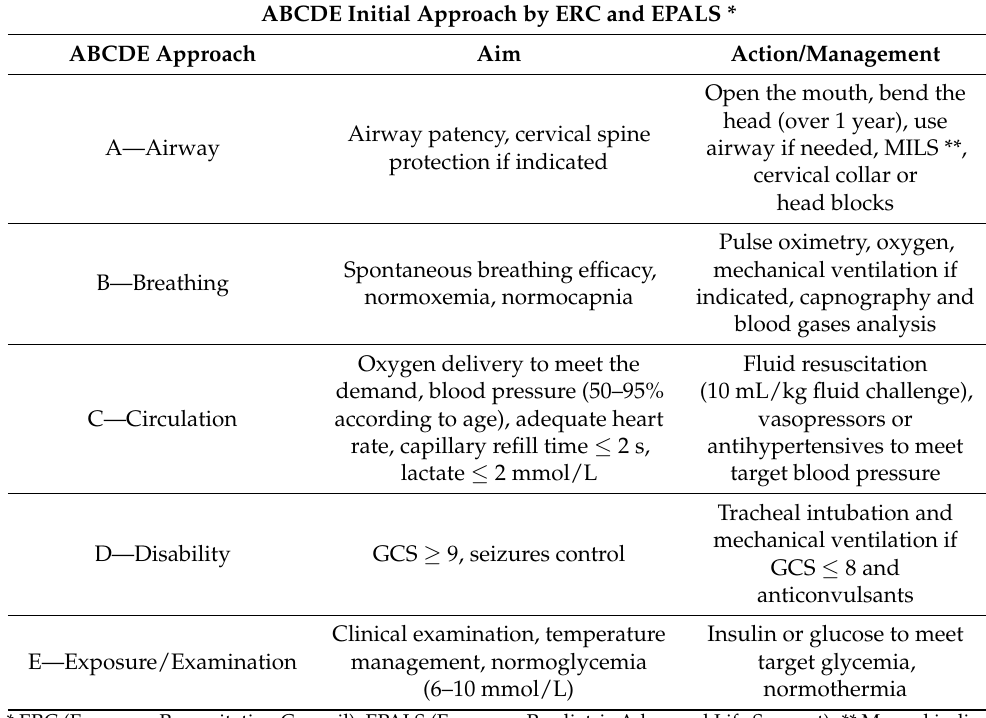
Table 3. Recommended initial approach to patients at